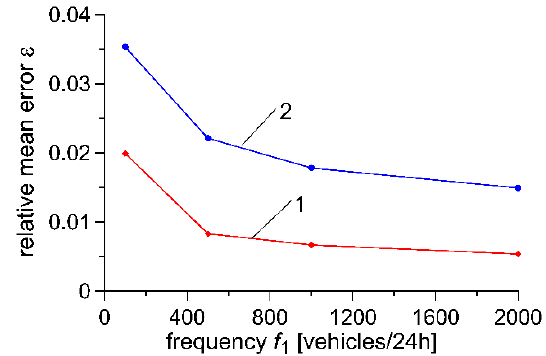
Figure 6. Impact of flow of reference vehicles f 1 on vehicle weighing error: 1 – σ 1 = 0.02, 2 – σ 1 = 0.10.